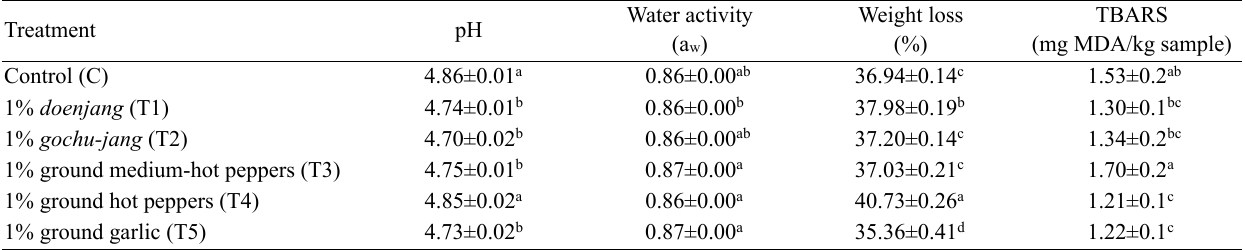
Table 2. Technological quality traits and lipid oxidation of fermented sausages as affected by the seasonings addition 1